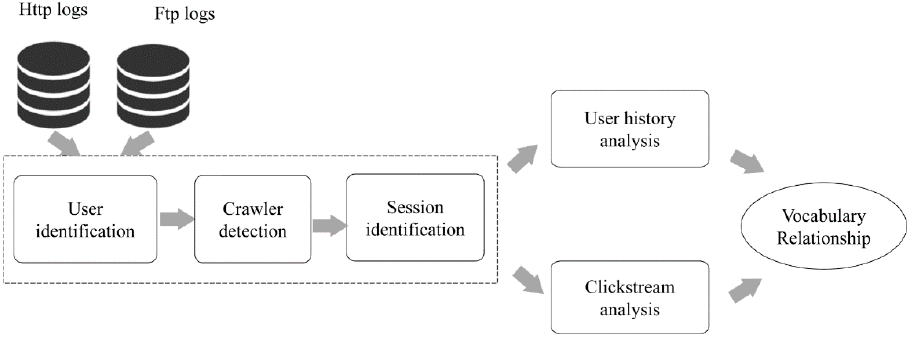
Figure 1. The components of log mining in the Mining and Utilizing Dataset Relevancy from Oceanographic Dataset (MUDROD) search engine.